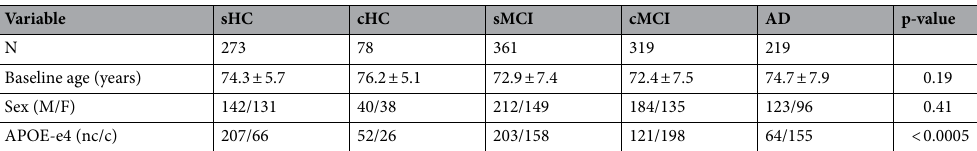
Table 1. Characteristics of the longitudinal ADNI sample used. Baseline age values are in mean ± standard deviation. M = male, F = female, nc = non-carriers, c = carriers. p-values indicate differences between group. We used ANOVA for baseline age, and Fisher’s exact test for the other data.